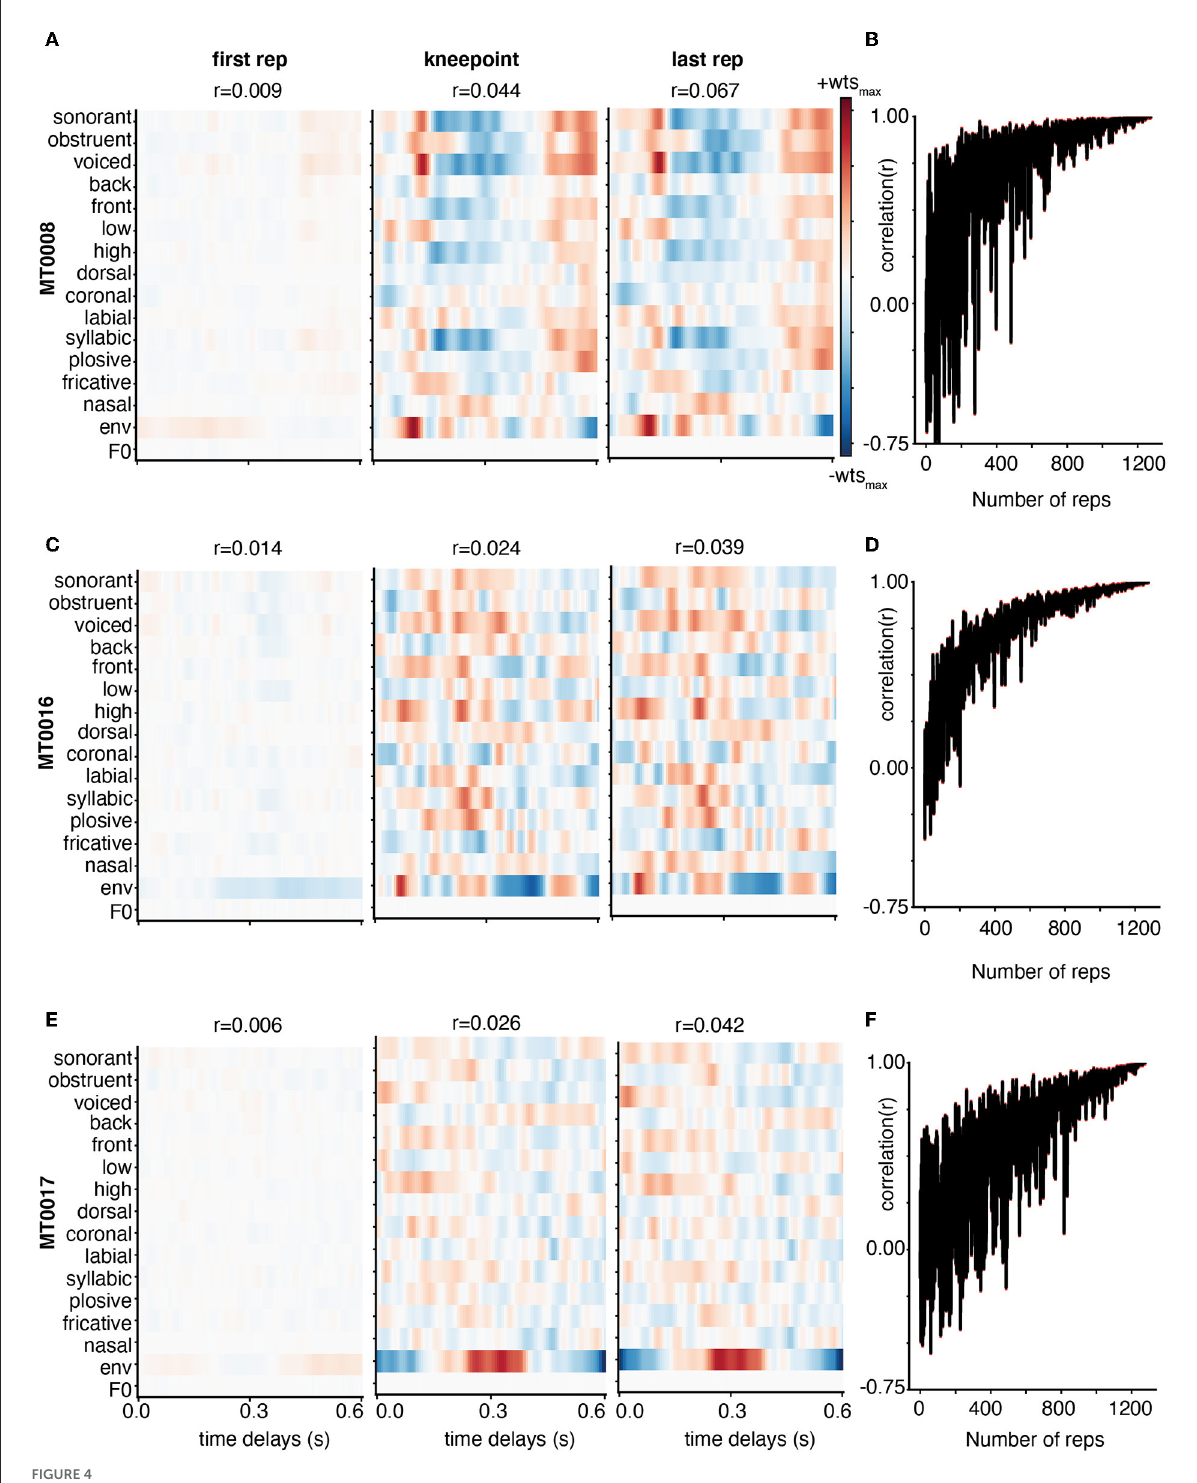
FIGURE4 Weight stabilization for three subjects with varying model performance using Movie Trailers. (A, C, E) are the same as described in Figure 3, but instead use the same subjects to show weight stability across the number of repetitions for movie trailers. Here, the receptive field structure appears to emerge at the knee point and final repetition in all three cases. (B, D, F) show the correlation of the receptive field at repetition N with the receptive field at repetition N-1. At first, receptive fields are relatively unstable as reflected by oscillating correlations, but then they stabilize as data are